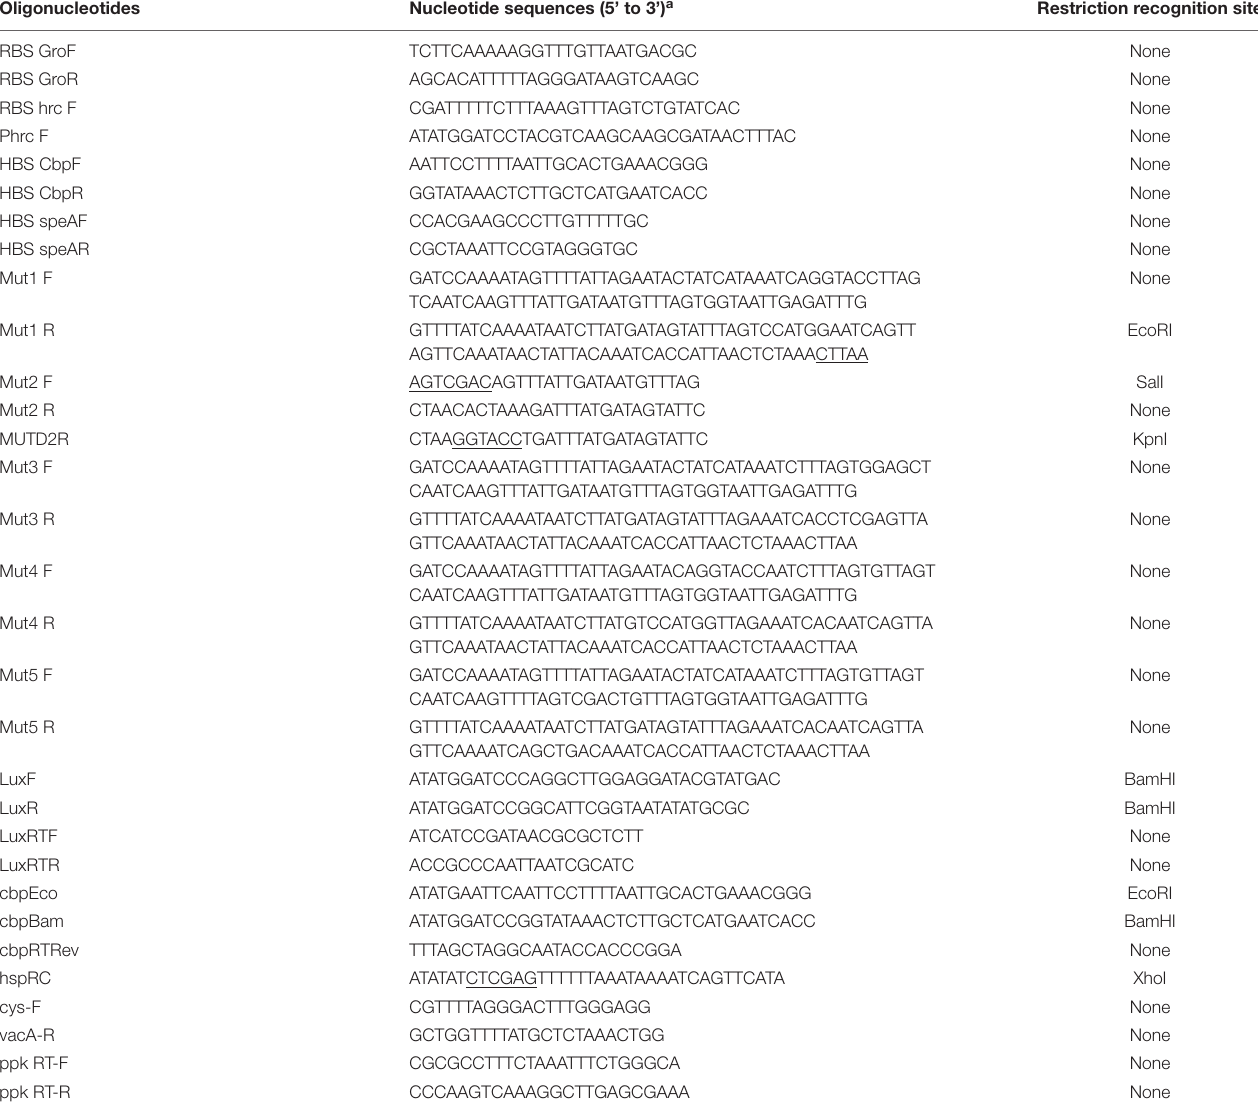
TABLE 2 | Oligonucleotides used in this study. Oligonucleotides Nucleotide sequences (5’ to 3’) a